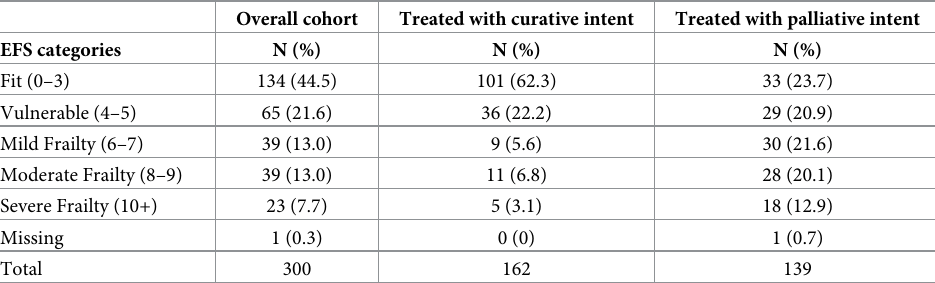
Table 3. Distribution of EFS categories.